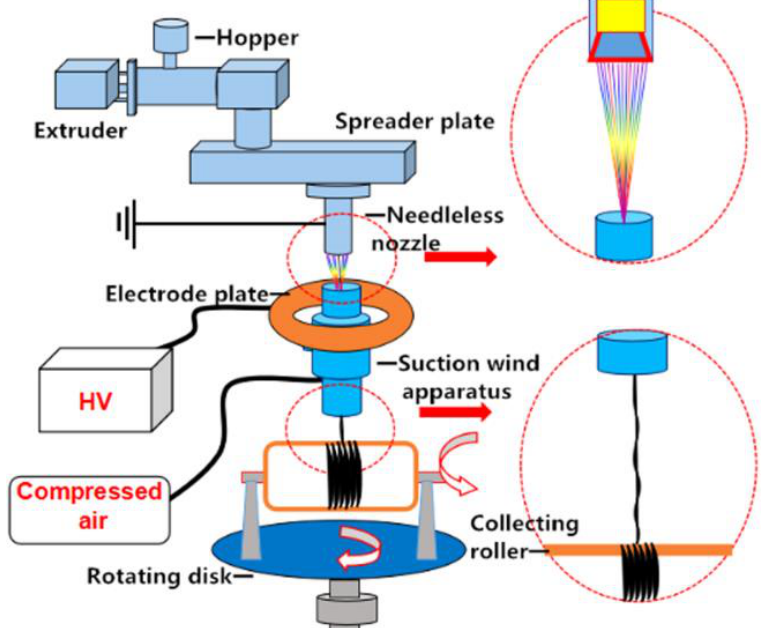
Figure 4. Yarn melt electrospinning: The small dotted circles located around the exit of needles nozzle and the suction wind apparatus are magnified in big dotted circles on the right side, each is pointed out by a red solid arrow to show the role of the suction wind apparatus in combining multiple fibers into one fiber. The hollow red arrows show a vertical and horizontal rotation direction of the collecting roller and rotating disk, respectively. [48].